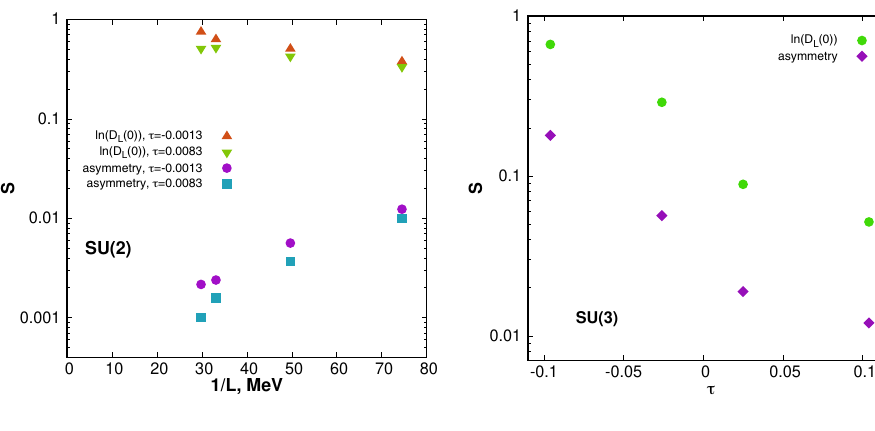
Figure 5: Fraction of variance unexplained: the dependence on lattice size is shown in the SU(2) case (left panel), the dependence on the temperature – for the SU(3) case (right panel) both for and A